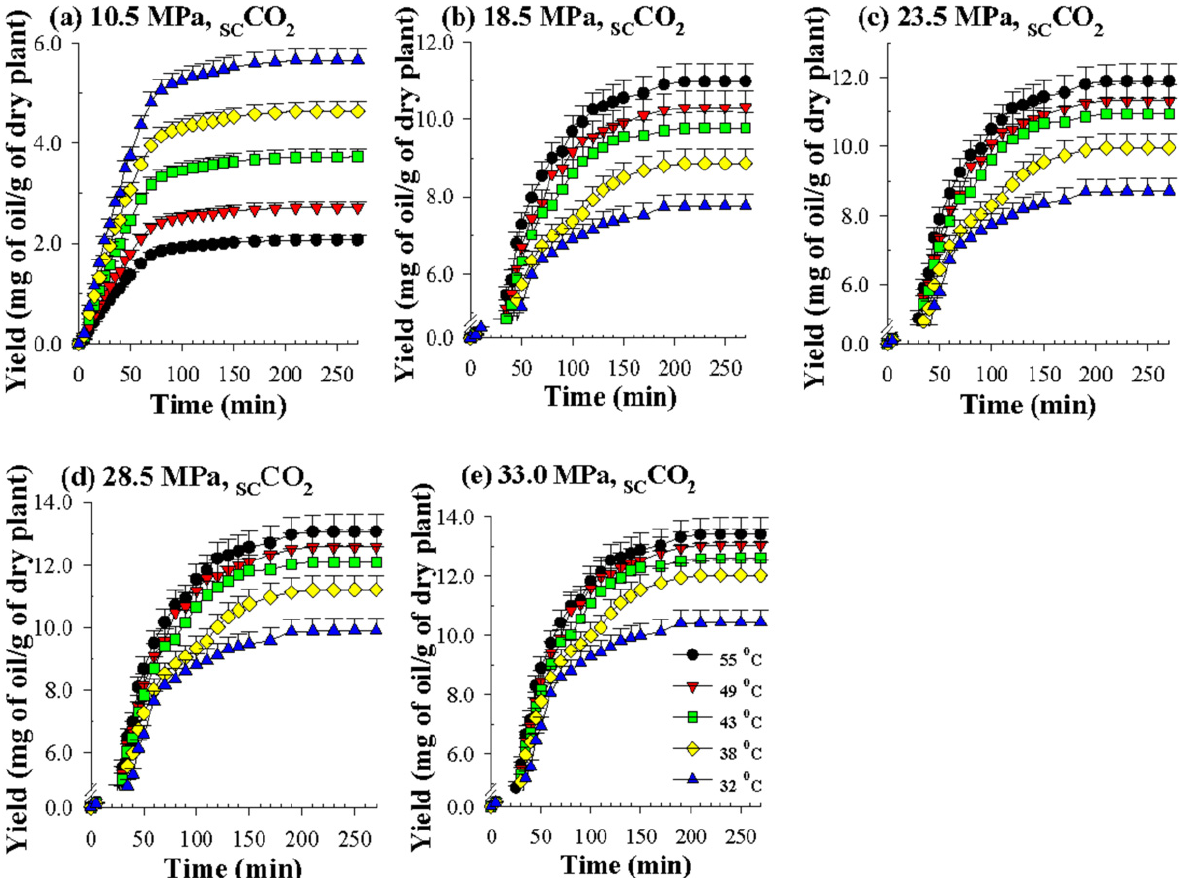
Figure 3. Overall extraction curves for SC CO 2 dynamic extraction of volatile oils from P. frutescens leaves at various temperatures and pressures ( a – e ) and a CO 2 flow rate of 0.37